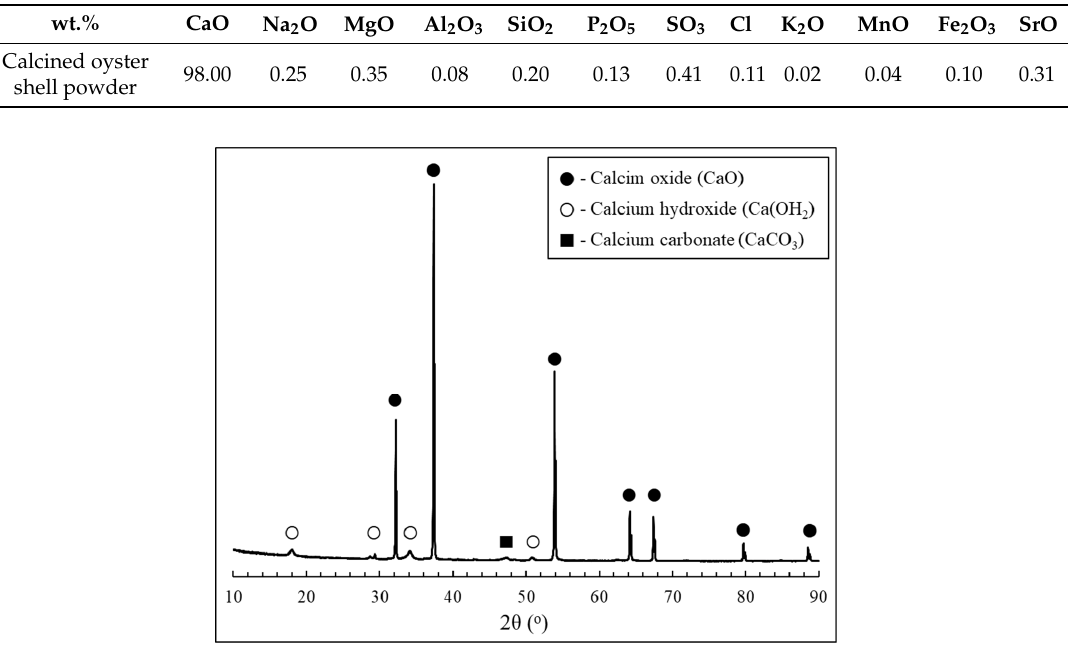
Figure 3. XRD pattern of calcined oyster shell powder.